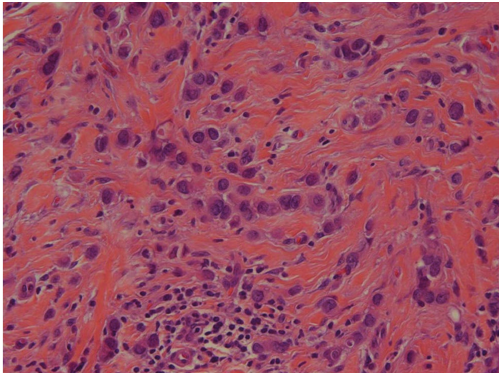
Figure 3: Pericolonic lymph node with positive mammaglobin staining.